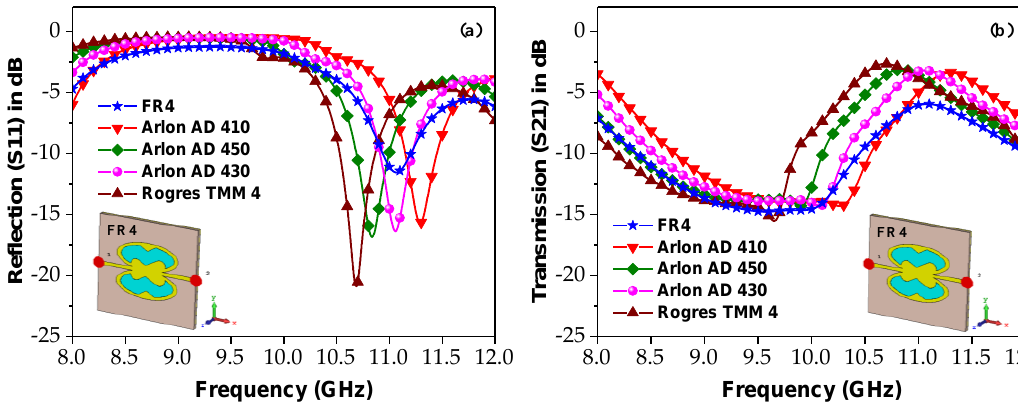
Figure 10. ( a ) Simulated variation effect of materials of the substrate layer on the resonant frequency in the reflection and ( b ) transmission spectra.